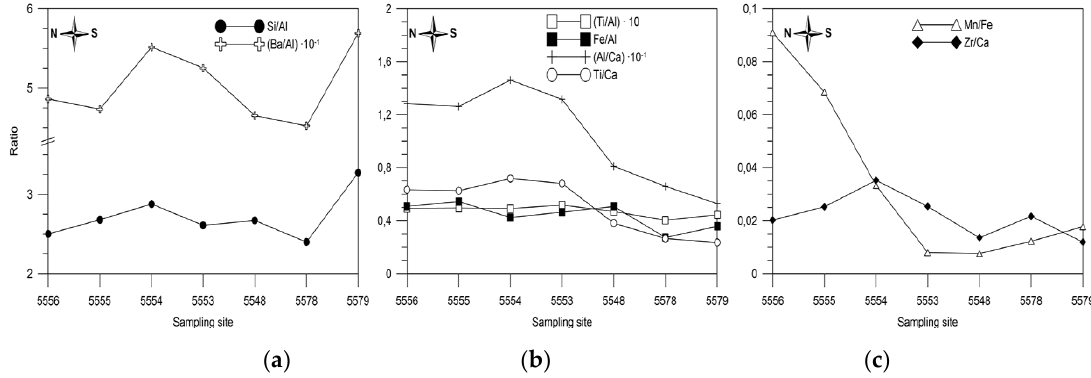
Figure 16. Variation of elemental ratios in surface sediments at the Kola Transect along the 32.400° E, the Barents Sea: ( a ) Si/Fe, Ba/Al; ( b ) Ti/Al, Fe/Al, Al/Ca, Ti/Ca; and, ( c ) Mn/Fe, Zr/Ca.